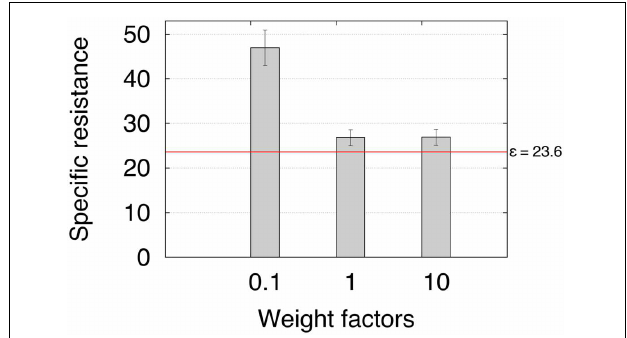
FIGURE 14 | Average specific resistance for the three different weight factors. The specific resistance has been determined by measuring power consumption and travel time (see Table 1 ) of a 1m distance with an obstacle on the way. The results suggest that a certain degree of backbone joint motion is necessary to produce energy-efficient obstacle negotiation behavior. The red line denotes the specific resistance for walking a 1 m distance without an obstacle in the